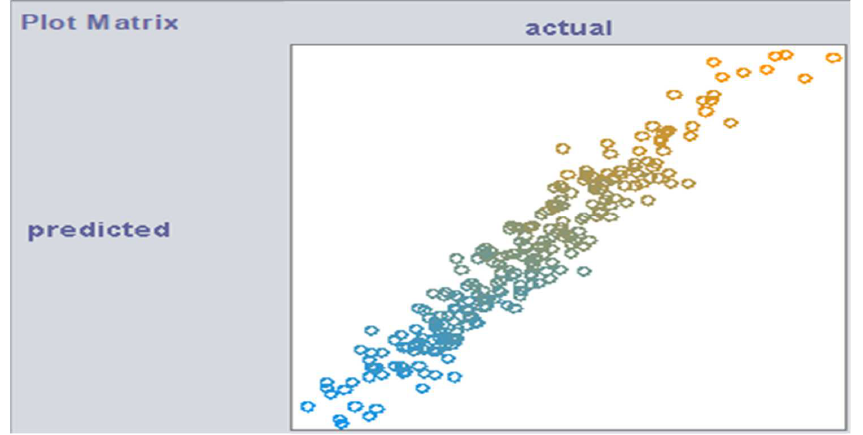
Figure 9. Plot of predicted and actual values for three-parameter subset.